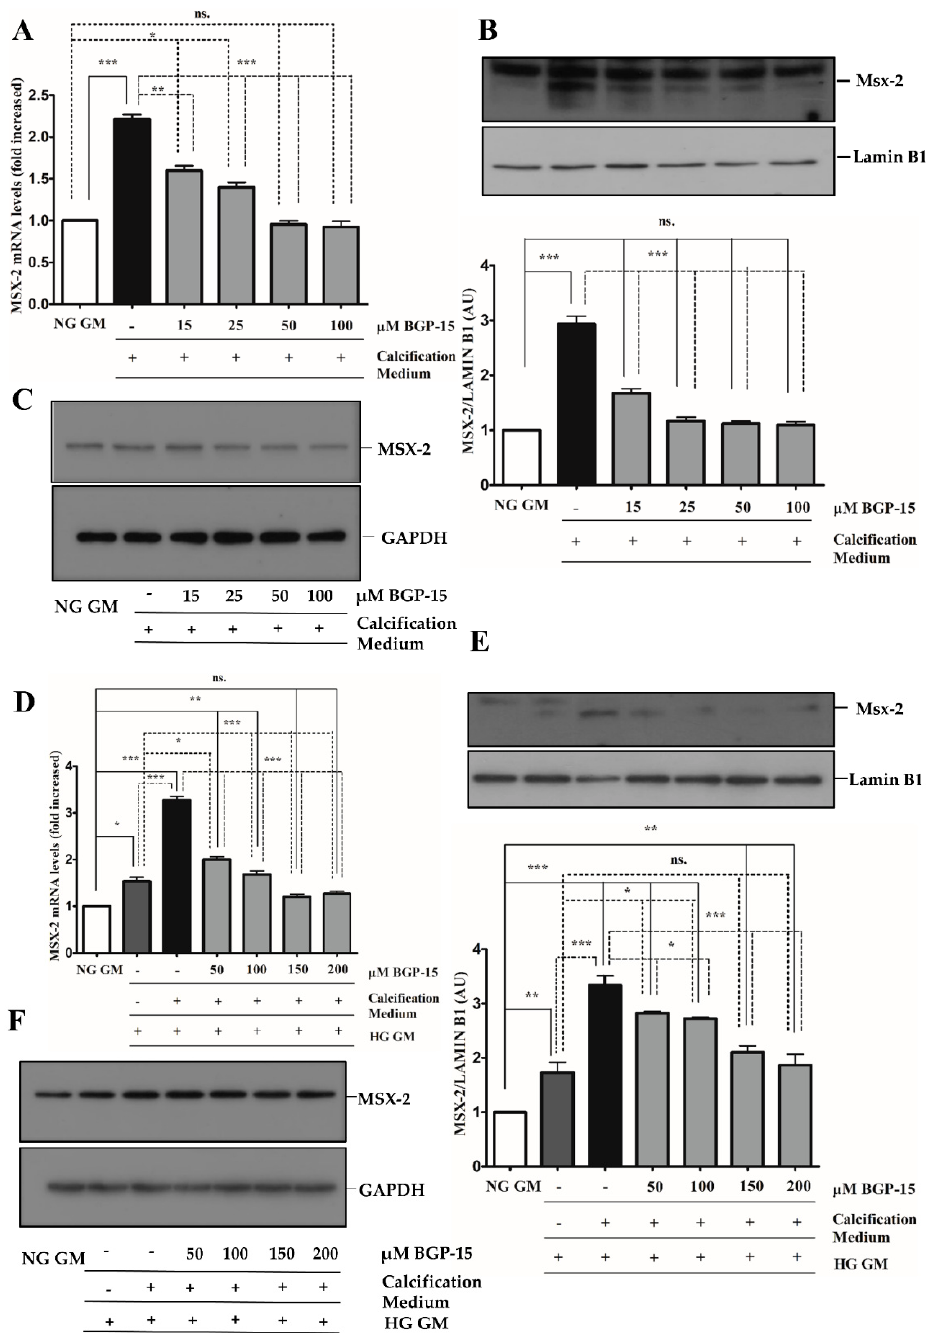
Figure 8. BGP-15 decreases Msx-2 expression and nuclear translocation induced by high Pi in NG and HG conditions. VSMCs were treated as in Figure 2. Expression of Msx-2 was analyzed by RT-qPCR and immunoblot ( A – F ). Expression of Msx-2 was analyzed by RT-qPCR and immunoblot ( A – F ). Relative expression of Msx-2 mRNA ( A ) and protein ( B , C ) in NG condition (( B ): Protein from nuclear extracts normalized to Lamin B1; ( C ): Cytosolic fractions normalized to GAPDH). Relative expression of Msx-2 mRNA ( D ) and protein ( E , F ) in HG condition (( E ): Protein from nuclear extracts normalized to Lamin B1, ( F ): Cytosolic fractions normalized to GAPDH). Data are presented as mean ± SEM of three independent experiments. Relative mRNA expression was normalized to RNA45S. Statistical analysis was performed by the one-way ANOVA test followed by Bonferroni correction. A value of p < 0.05 was considered significant. * p < 0.05, ** p < 0.01, *** p < 0.001.